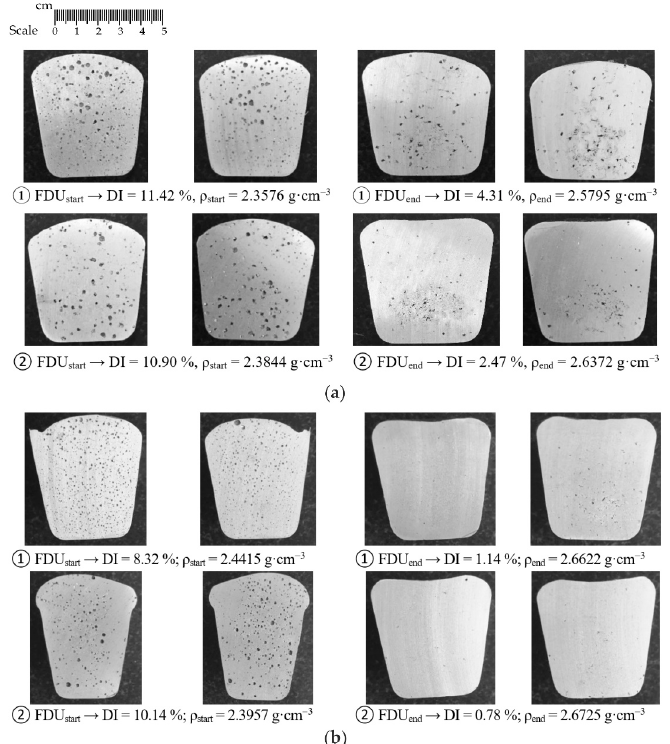
Figure 5. Sections of samples taken for gasification assessment for rotor A1: ( a ) wear 0% (series 1/VT); ( b ) wear 100% (series 5/VT).